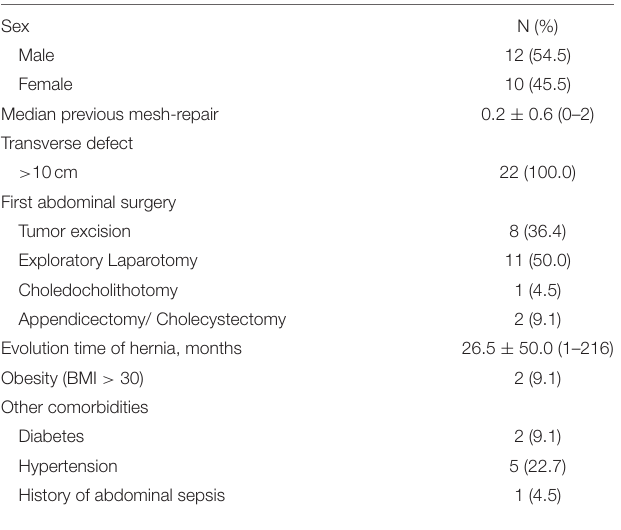
TABLE 1 | Demographics and characteristics of the patients with complex ventral hernia.